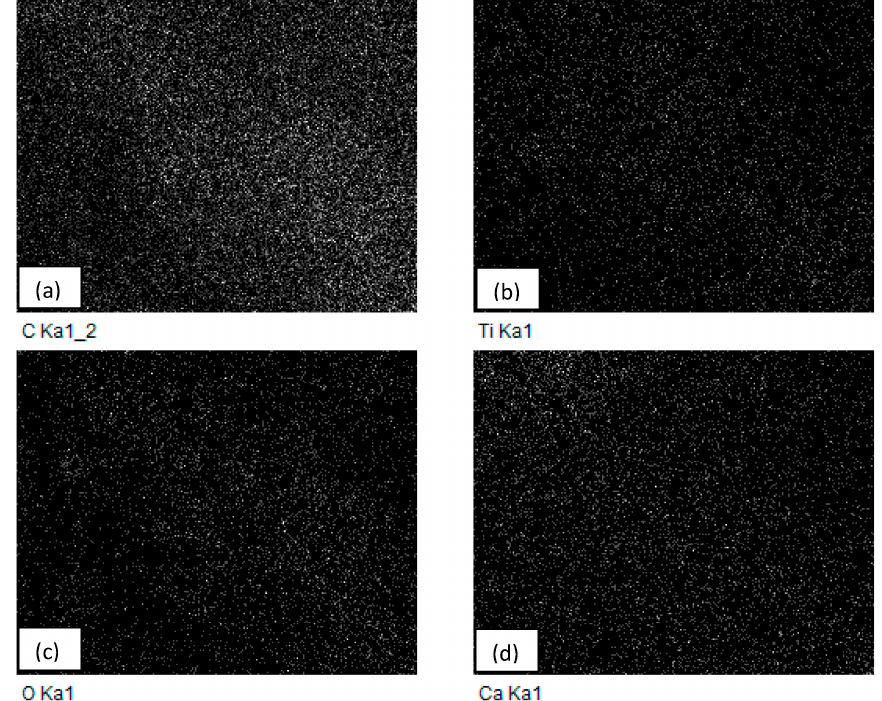
Figure 4. A representative elemental mapping by EDS spectroscopy on injection molded HDPE/TiO 2 nanocomposite fabricated under a barrel temperature of 250 °C and a residence time of 50 min. Images represent the distribution of the different chemical elements on the nanocomposite surfaces: ( a ) carbon; ( b ) titanium; ( c ) oxygen; and ( d ) calcium.